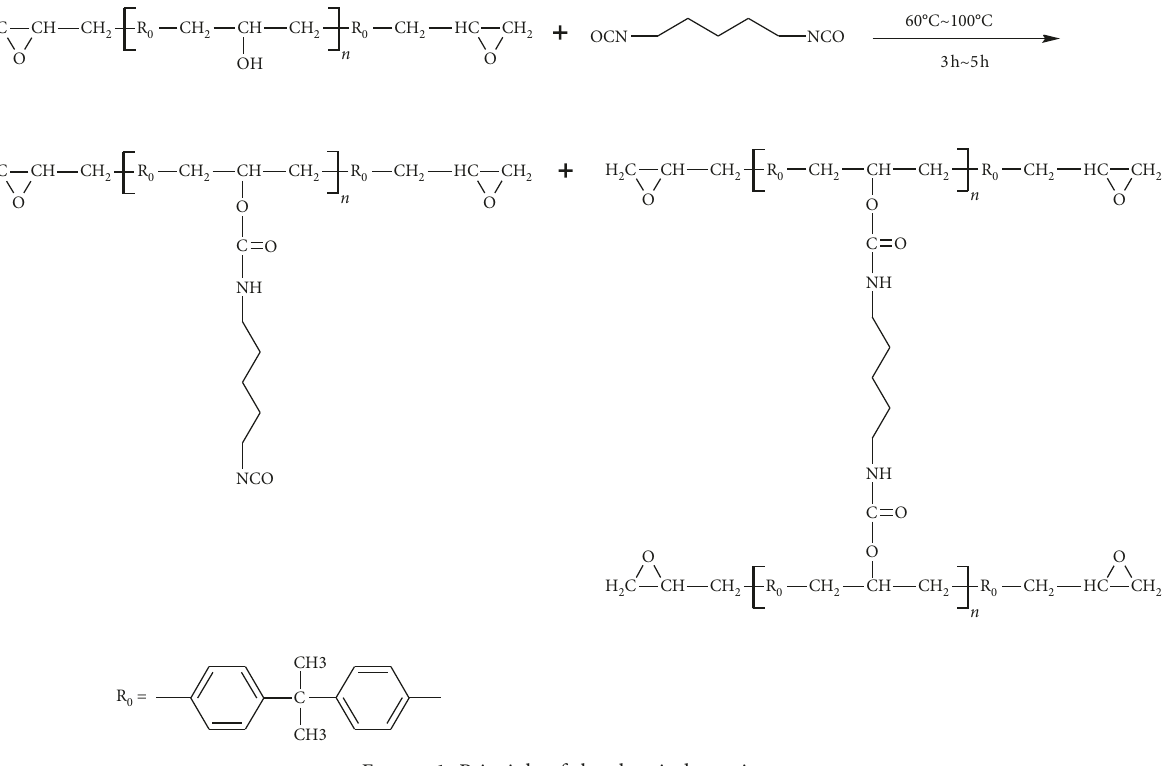
Figure 1: Principle of the chemical